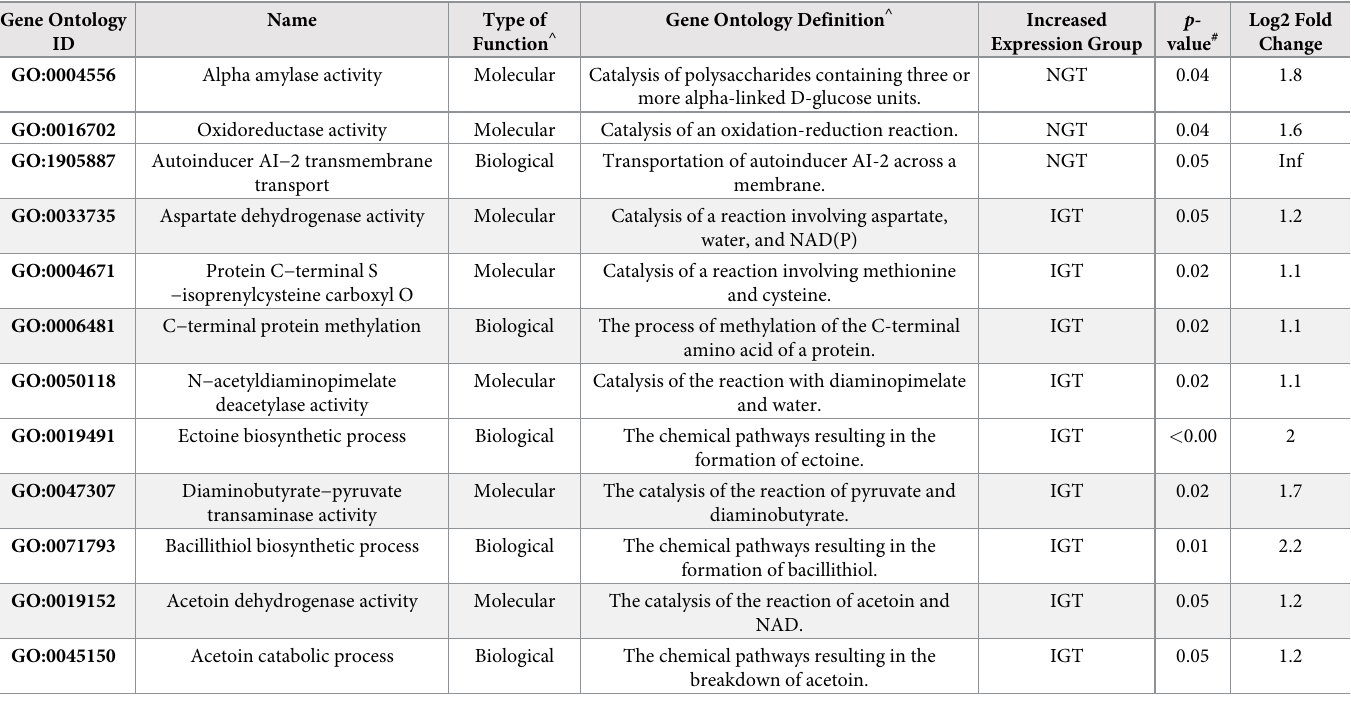
Table 4. GO terms significant in between IGT and NGT groups.